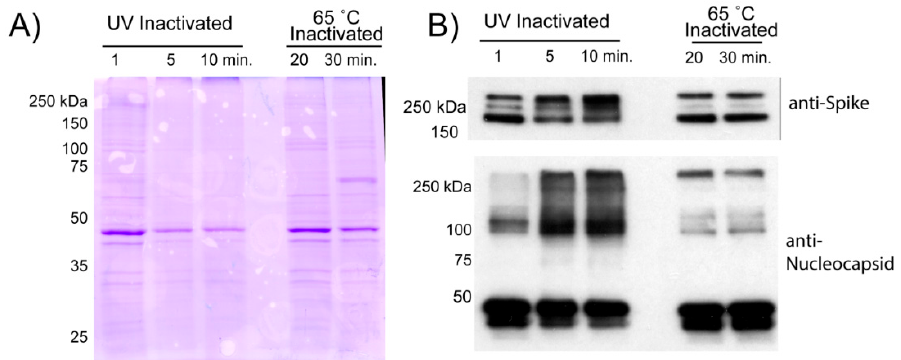
Figure 3. Comparison of virion protein quality following inactivation. Viral supernatants inactivated by UV or Heat exposure were loaded onto a two-step sucrose gradient and subjected to ultracentrifugation. The resulting pellets were resuspended in PBS and analyzed for protein content. ( A ) 5 µg of resuspended pellets from the two inactivation conditions were loaded onto a 10% SDS-PAGE gel that was then subjected to Coomassie staining. ( B ) 0.2 µg of each pellet was run on a 10% gel and transferred to PVDF membrane for Western analysis for SARS-CoV-2 Spike or Nucleocapsid. Protein extracted from SARS-CoV-2 infected cells was run as a positive control.